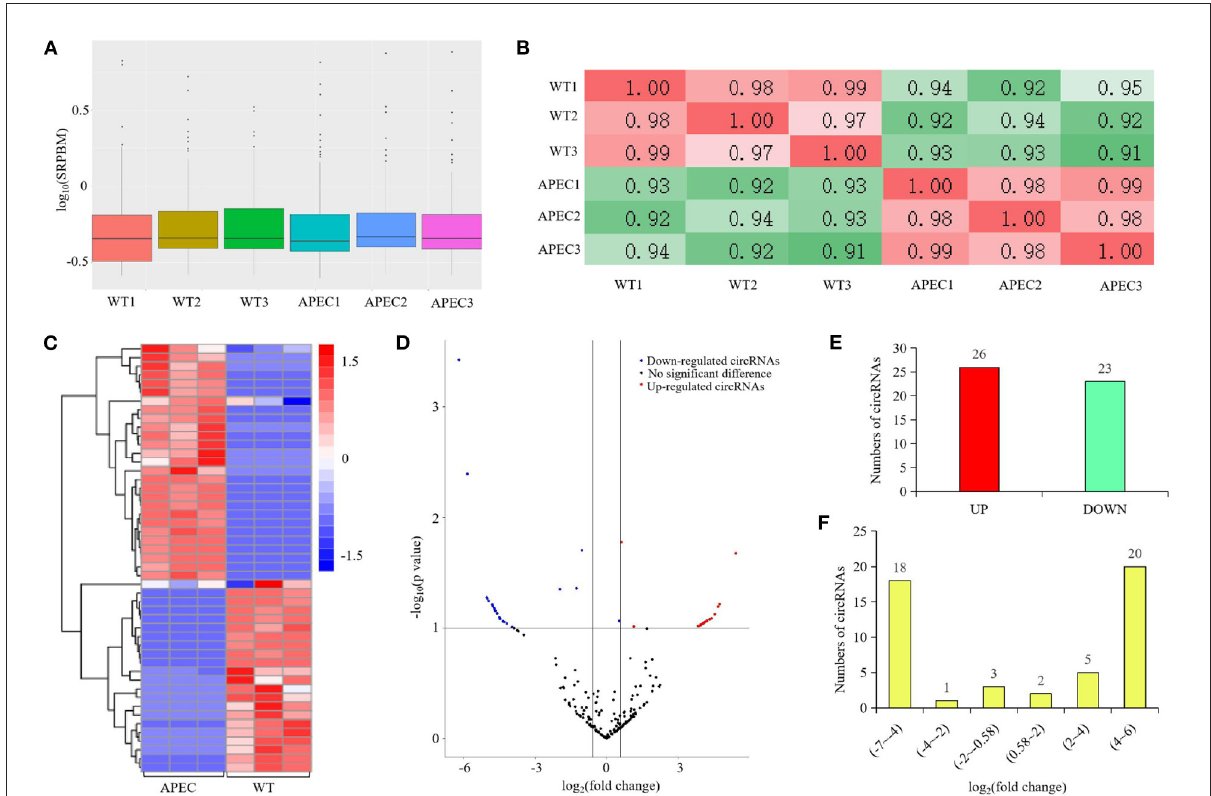
FIGURE2 circRNA-seq profiling in the comparisons of avian pathogenic E. coli infected HD11 cells (APEC) vs. wild type HD11 cells (WT). (A) Density plot of expression distribution with density values on the vertical axis and logarithmic values of SRPBM on the horizontal axis. WT, wild type HD11 cells; APEC, avian pathogenic E. coli . (B) The heatmap of samples correlation. WT, wild type HD11 cells; APEC, avian pathogenic E. coli . (C) Heatmap analysis for the transcriptome data from the comparison of APEC vs. WT. Red color indicate up-regulation, while blue means down-regulation. (D) Volcano plot of circRNAs differential expression results. Red spots represent differentially expressed circRNAs for up-regulation, blue spots for down-regulation. (E) The expression levels of differentially expressed (DE) circRNAs in the comparison of APEC vs. WT. (F) The log 2 (fold change) distribution of the differentially expressed (DE) circRNAs in APEC vs.